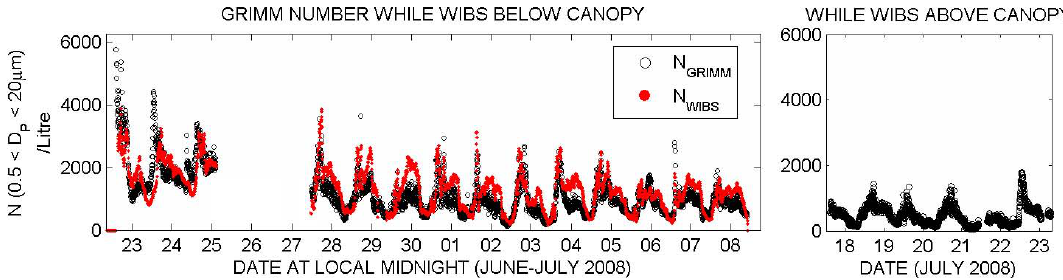
Fig. 8. Time series of understorey N GRIMM (0.5 ≤ D P ≤ 20µm) throughout the WIBS-3 measurement campaigns and understorey N WIBS . Instrument downtime occurred from 25–27